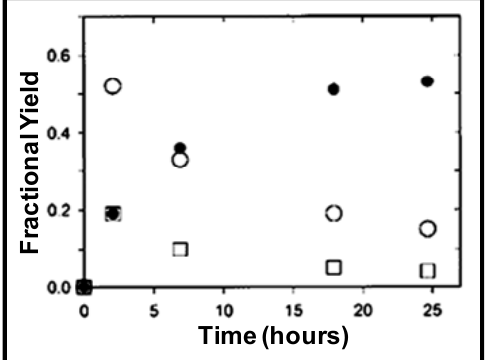
Figure 14. Acylation of resorcinol with acetic acid to products 2,4-dihydroxyacetophenone ( ● ) resorcinol monoacetate ( ○ ), and resorcinol diacetate ( □ ) in acetic acid at 290 °C